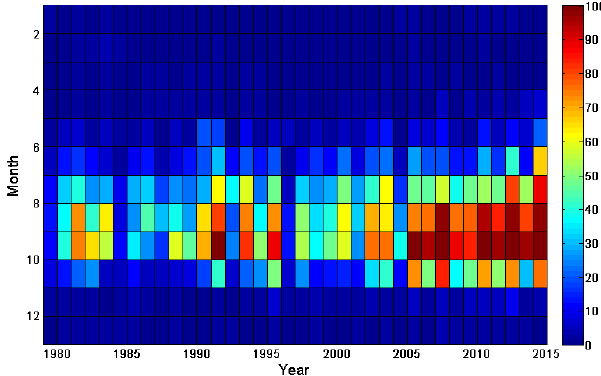
Figure 12. Percentage of ice-free area in the region: latitude 76 to 80 ◦ N, longitude 140 to 150 ◦ E (framed yellow in Fig. 1b), for each month from 1980 to 2014, evaluated from the passive microwave data of NSIDC (Cavalieri et al.,